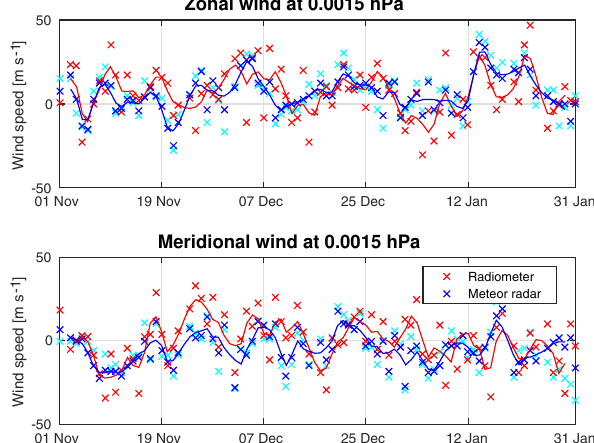
Figure A1. Observations of nighttime zonal and meridional wind in the mesopause region from the wind radiometer WIRA (red) and the Andenes meteor radar (dark blue: convolved with WIRA’s aver- aging kernels according to Eq. 2; cyan: raw) for the winter months of 2016/17. The crosses denote the nightly averages whereas the coloured lines show a smoothed version of the data by a moving average filter with a span of 5